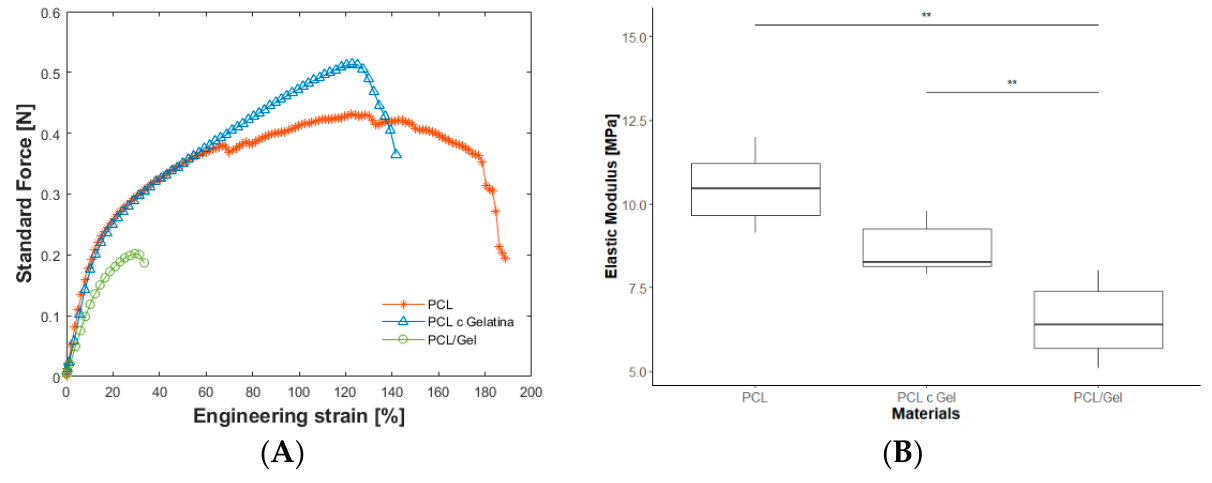
Figure 3. ( A ) Example of mechanical behavior of the scaffolds. ( B ) Boxplot of different materials showing the elastic modulus of PCL, PCL gelatin coating and PCL/gelatin 80:20 (** p < 0.05).